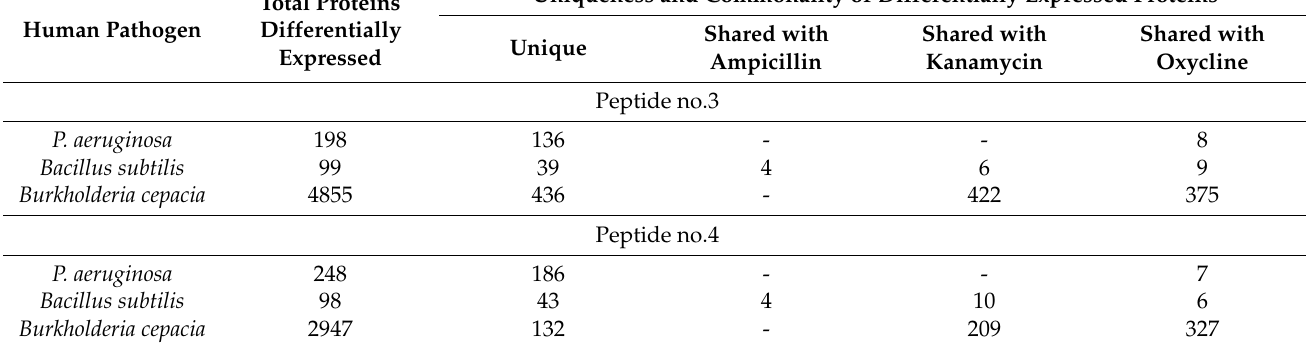
Table 3. Summary of differentially expressed proteins in human pathogenic bacteria treated with peptide no.3, peptide no.4, and